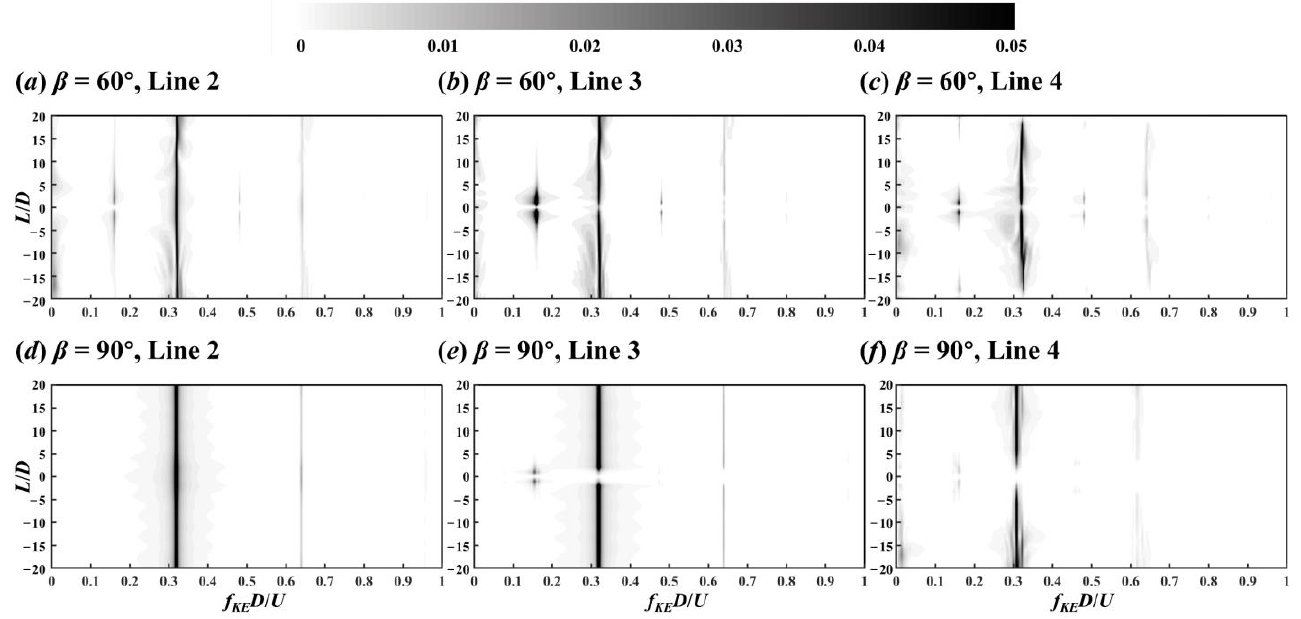
Figure 10. Contour of PSD calculated by the KE along lines 2, 3, and 4 in the wake of the two crossing cylinders in 60° ( a – c ) and 90° ( d – f ) arrangements. cylinders in 60 ◦ ( a – c ) and 90 ◦ ( d – f )